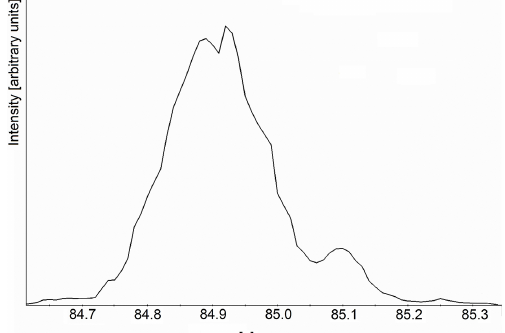
Table 7. The reproducibility (REP) for the QP MS and the TOF MS as a mean value of two measurement series with 20 measurements each and a preconcentration volume of 1.00L. The given errors are 1 σ standard deviation over two reproducibility experiments.